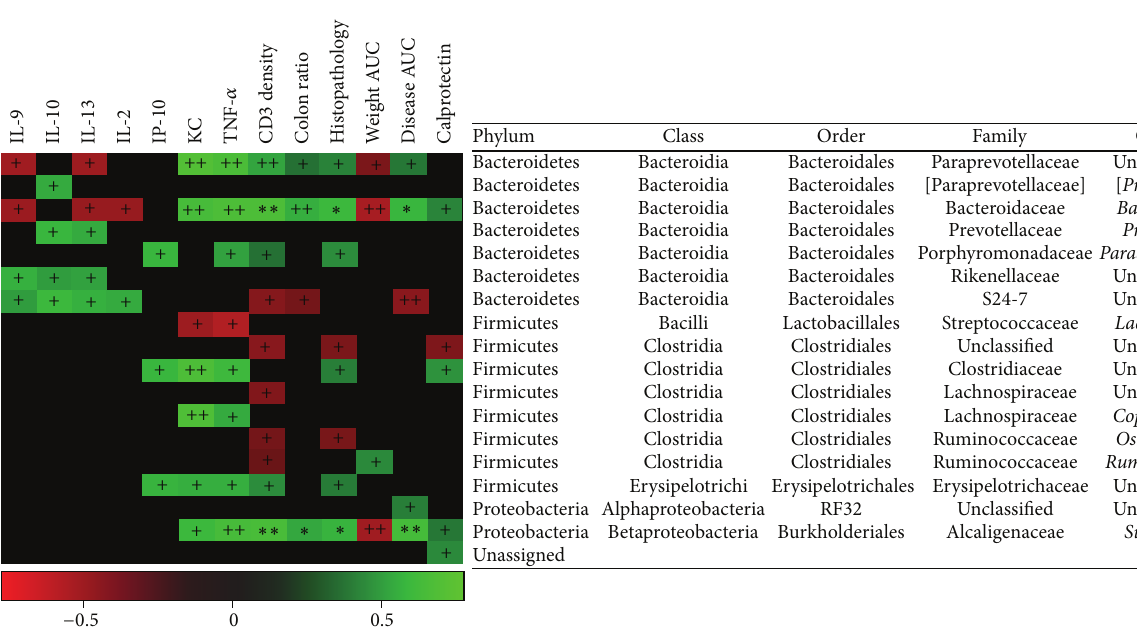
Figure 4: Pearson’s correlation of immunological and host parameters with changes in the relative distribution of microbiota members of the colonic content. On top of the heat map the immunological and host parameters are depicted. The lineages are marked on the right and are represented by five major taxonomic ranks. Symbols describing significant correlations were defined as follows: for 𝑝 value, + ≤ 0.05 and ++ ≤ 0.01. For 𝑞 -value (False Discovery Rate correction), ∗ ≤ 0.05 and ∗∗ ≤ 0.01. A matrix containing the 𝑟 -values for every significant correlation is shown in Supplemental Table 4.